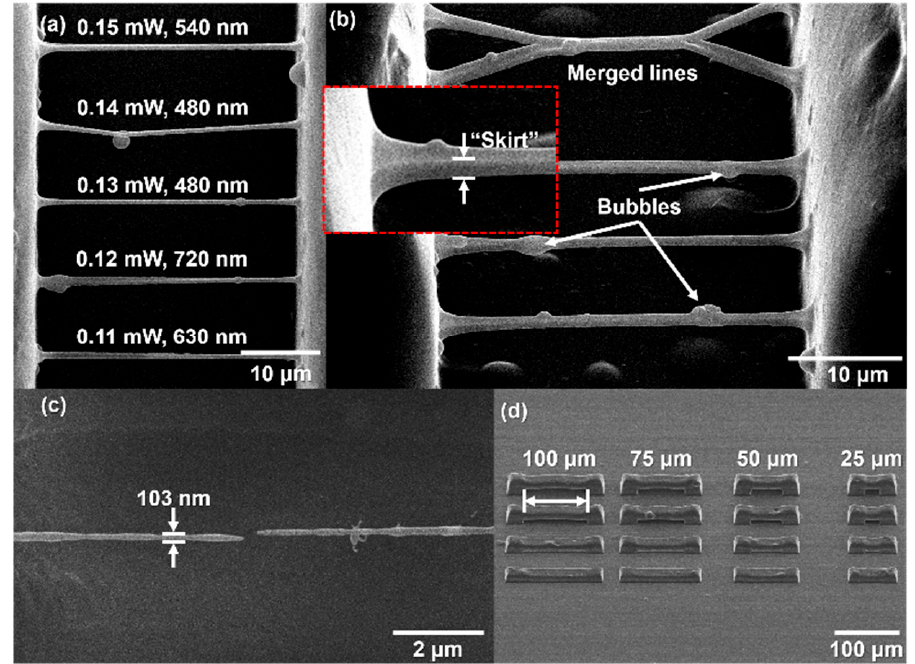
Figure 6. The SEM images of produced objects via laser direct writing (LDW). ( a ) RB manufactured with P = 0.11 − 0.15 mW ( I = 0.3–0.4 TW/cm 2 ) at v = 3 mm/s. Averaged line width is depicted in nm; ( b ) RB manufactured with the same P but at v = 2 mm/s. Common defects are showed: merged lines, formed bubbles and residual material called “skirt”; ( c ) The thinnest observed feature of 103 nm; ( d ) Bulky arc-type objects. Distance between columns is marked with arrowed line and presented in numbers; ( a , c ) are top view of the structures, ( b , d ) were obtained at 45 degrees angle.